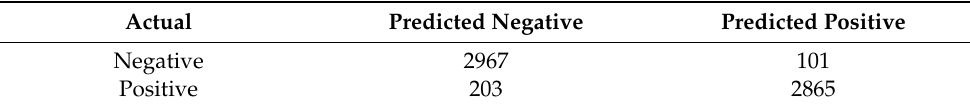
Table 15. Confusion matrix for NB model (training).